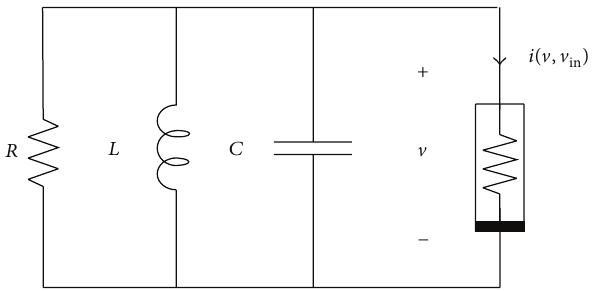
Figure 1: Equivalent circuit of an injection-locked frequency